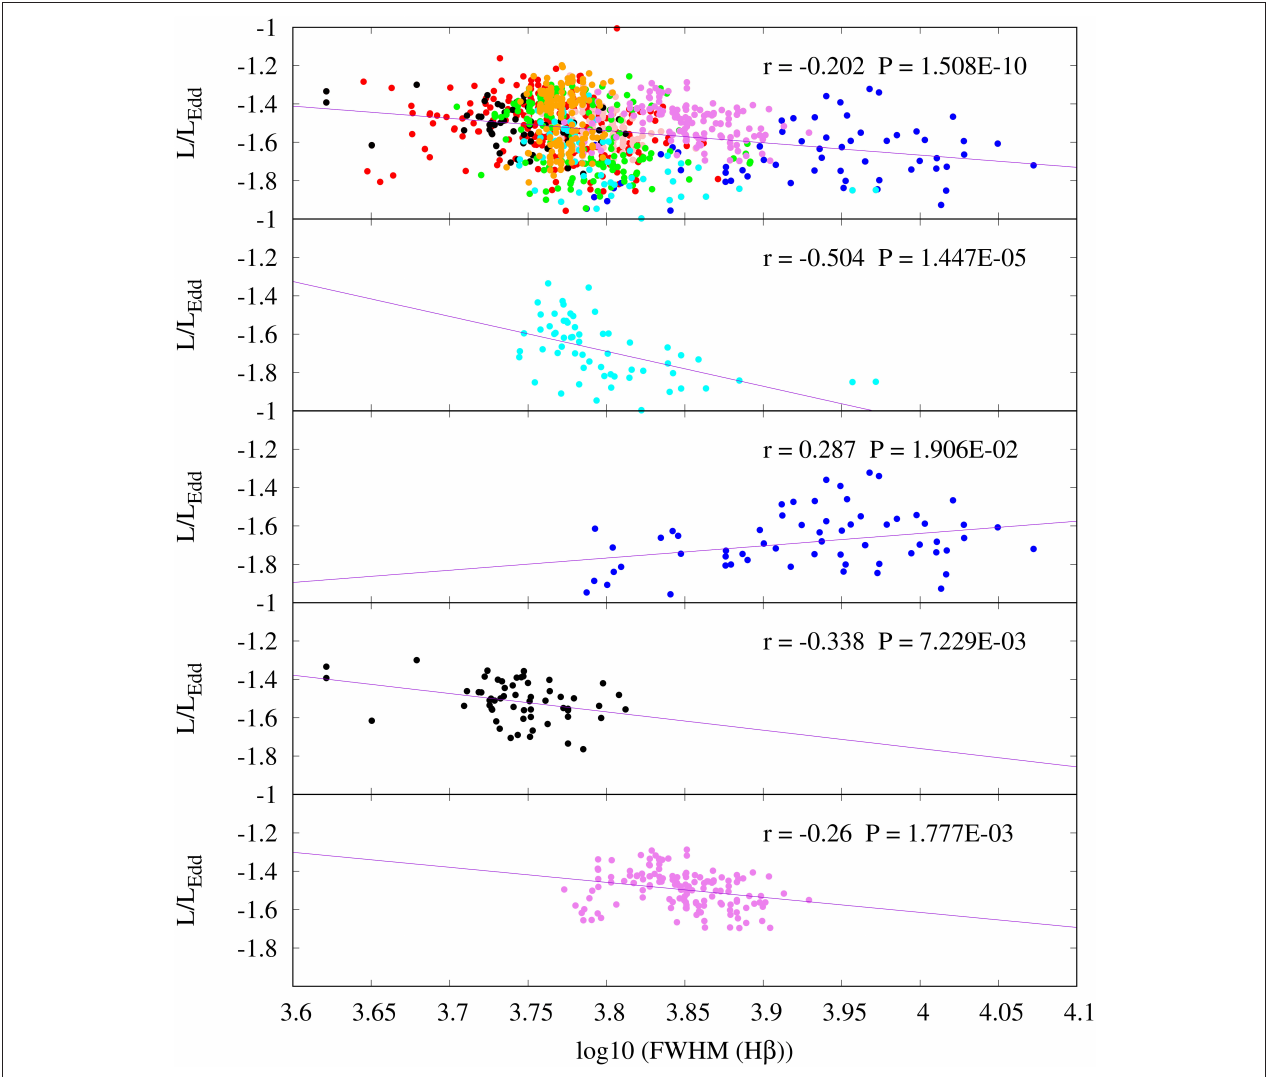
FIGURE 5 | L / L Edd vs. log 10 ( FWHM ) trends for long term ( top ) and short term variations ( middle and bottom ). Correlation coefficients are marked on each plot. Colors correspond to those presented in Figure 1 , 2 .